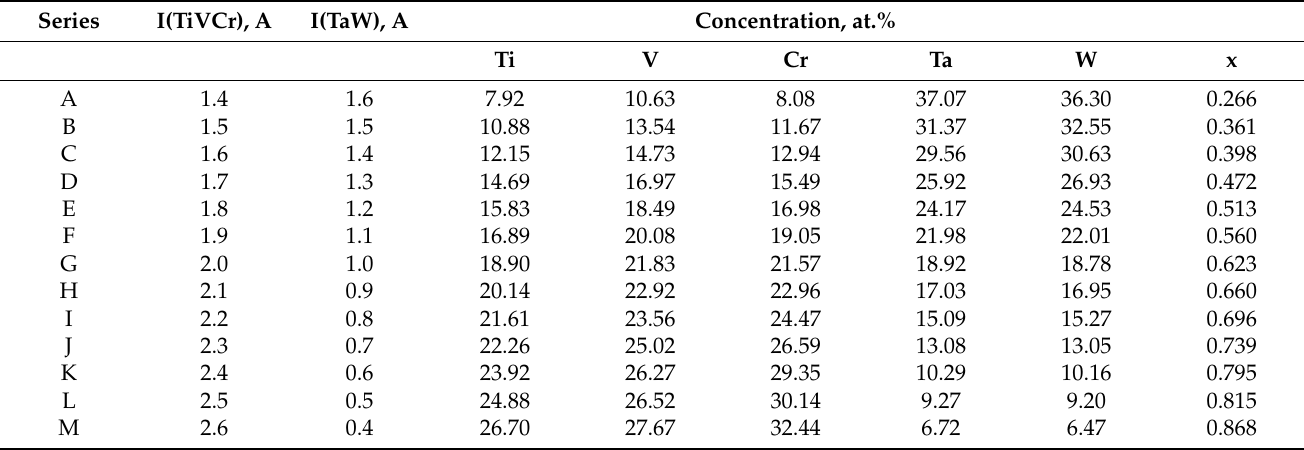
Table 1. (TiVCr)x-(TaW)1-x (A-M) binary system HEA film-deposition process parameters and alloy elemental